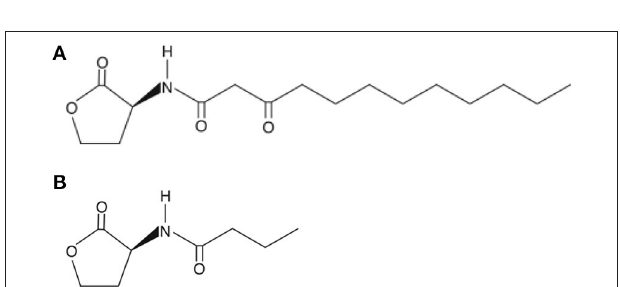
FIGURE 1 | Scanning electron micrographs of Candida albicans colonized by Pseudomonas aeruginosa PAO1 showing adhesion to C. albicans hyphae. Scale bars represent (A) 10 µ m and (B) 1 µ m. Co-culture of C. albicans and P. aeruginosa was performed and visualized by Ruan